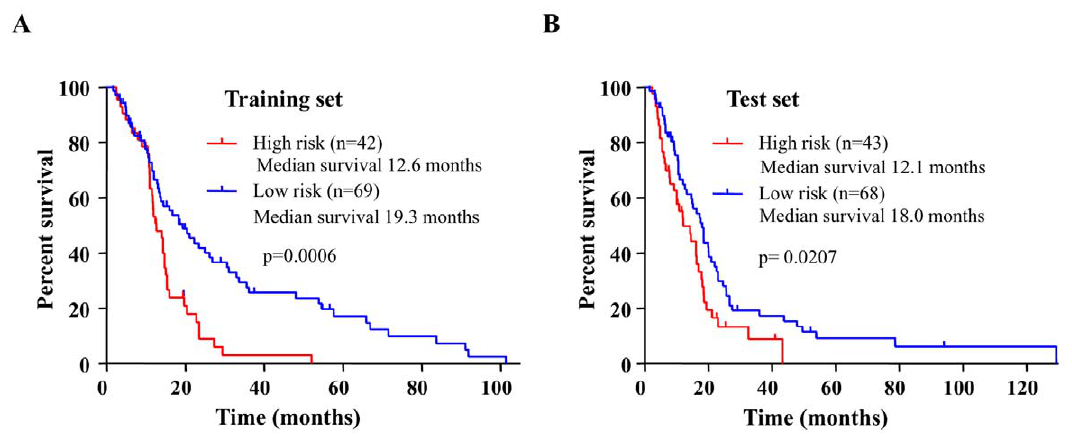
Figure 1. Kaplan-Meier survival estimates overall survival of glioblastoma patients according to the 10 miRNA expression signature. A ) 111 GBM patients in the training data set. B ) 111 GBM patients in the testing data set.